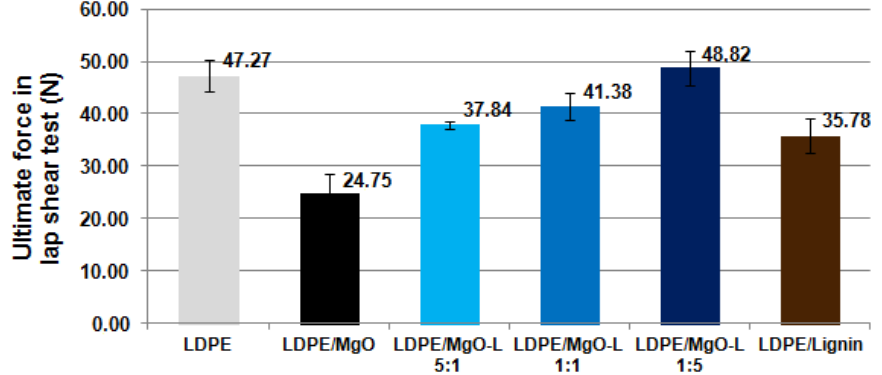
Figure 7. Comparison of the ultimate shear force applied in lap shear test.